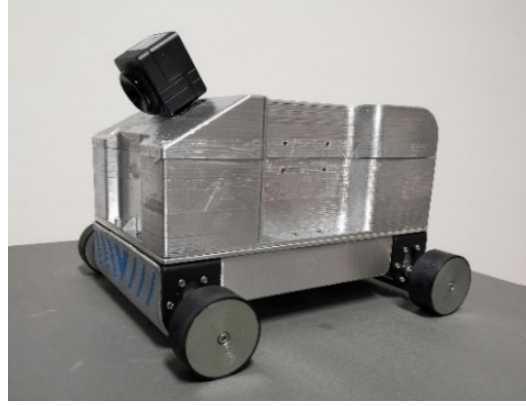
Figure 2. Prototype of the wall-climbing robot.